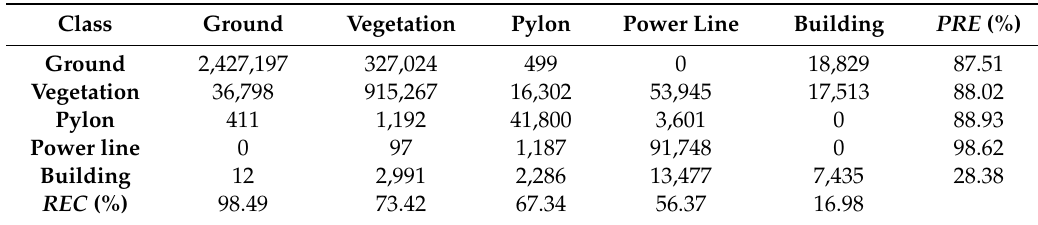
Table 7. The confusion matrix and performance measures of site III (classifier = RF, feature set = F 0 , class distribution = unbalanced, R = 1.5